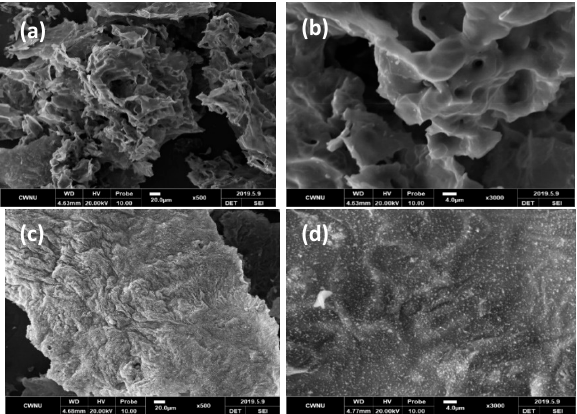
Figure 6. ( a , b ): SEM images of an Ep/IFR charred layer with different amplifications; ( c , d ): SEM images of Ep/IFR/CuO-5% charred layers with different amplifications.